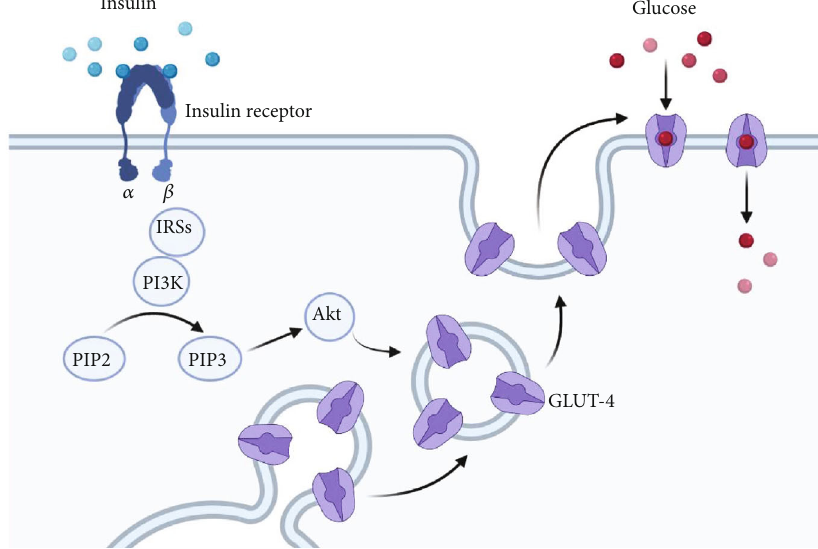
Figure 1: Simple schematic pic of insulin signal transduction (IRSs=insulin receptor substrates; PI3K=phosphoinositide 3-kinase; PIP2 =phosphatidylinositol 4,5-bisphosphate; PIP3 =phosphatidylinositol 3,4,5-trisphosphate; Akt=protein kinase B; Glut-4=glucose transporter type 4).